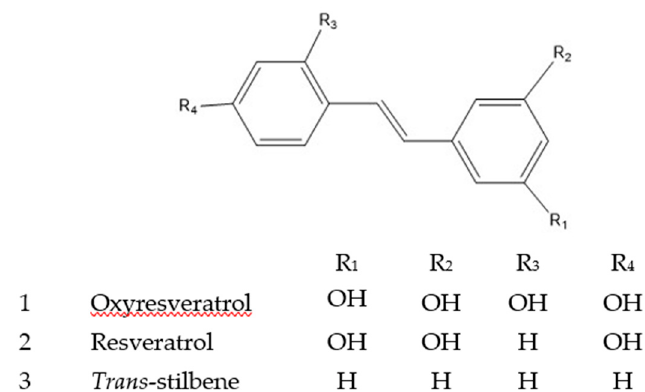
Figure 1. Chemical structure of oxyresveratrol, resveratrol and trans -stilbene.